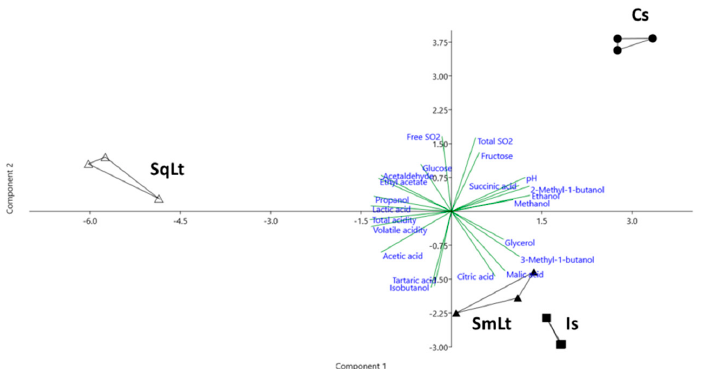
Figure 3. Principal component analysis PCA of the chemical characteristics of wines produced from pasteurized grape must. The first two principal components (PC1 and PC2) accounted for 54.4% and 32.3% of the total variation, respectively. Cs—commercial S. cerevisiae ; Is— S. cerevisiae